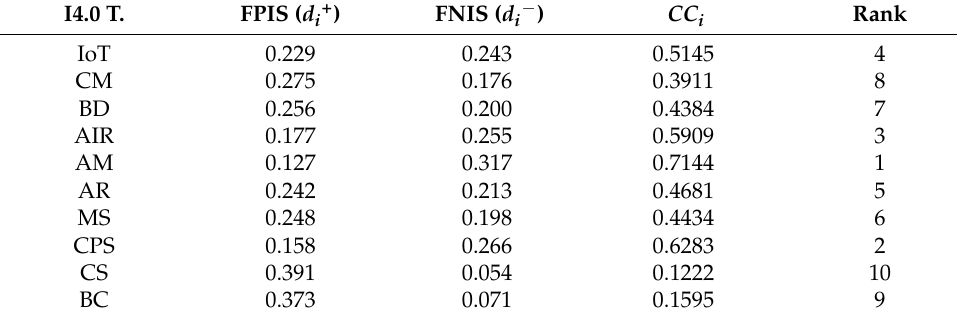
Table 11. Fuzzy TOPSIS final